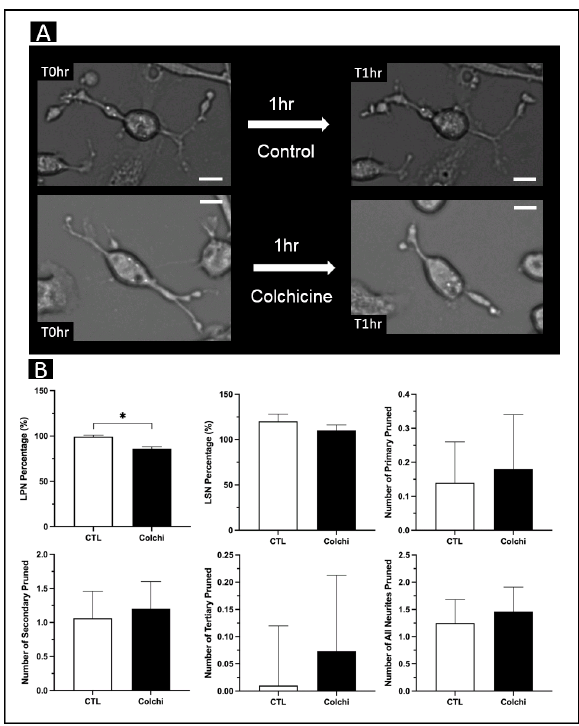
Figure 2. Whole-cell tracing of MDNCs after treatment with colchicine 0.5 µ M. ( A ) Light microscopy photographs of the exact same MDNCs before (T0 h) and after one hour (T1 h) under control conditions or after treatment with colchicine 0.5 µ M (20 × original magnification). Scale bar = 20 µ m. ( B ) Bar graphs comparing MDNCs’ structural response to colchicine versus MDNCs under control conditions. Structural parameters include longest primary neurite (LPN), longest secondary neurite (LSN), number of primary neurites, number of secondary neurites, number of tertiary neurites and total number of neurites. Data are presented as mean ± SEM. Differences were assessed using the non-parametric Mann–Whitney test. For LPN, number of primary, number of secondary, number of tertiary and total number of neurites, n = 96 for control and n = 82 for colchicine. For LSN, n = 91 for control and n = 75 for colchicine. * p = or <